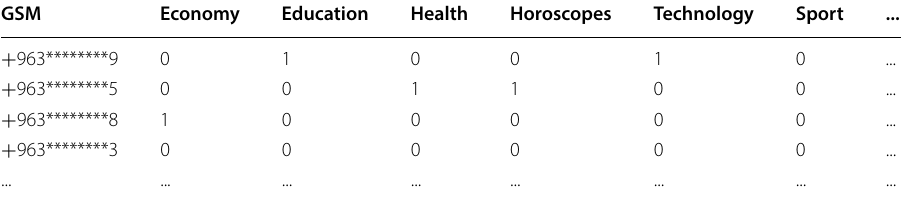
Table 2 Sample of customer’s services